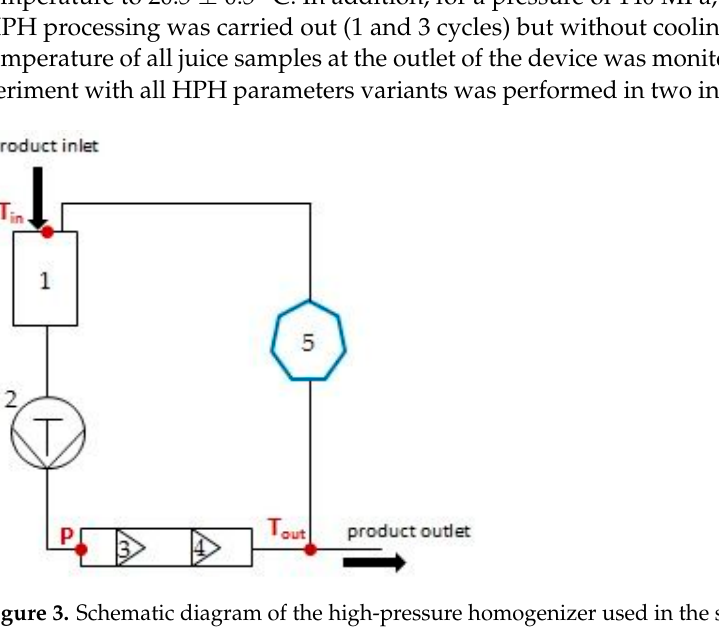
Figure 3. Schematic diagram of the high-pressure homogenizer used in the study. 1—feeding hopper, 2—piston pump, 3—first stage valve, 4—second stage valve, 5—intermediate container with cooling capability; T in —inlet temperature measured at the feeding hopper, P—summary pressure of first and second stage valves measured by digital manometer, T out —outlet temperature measured